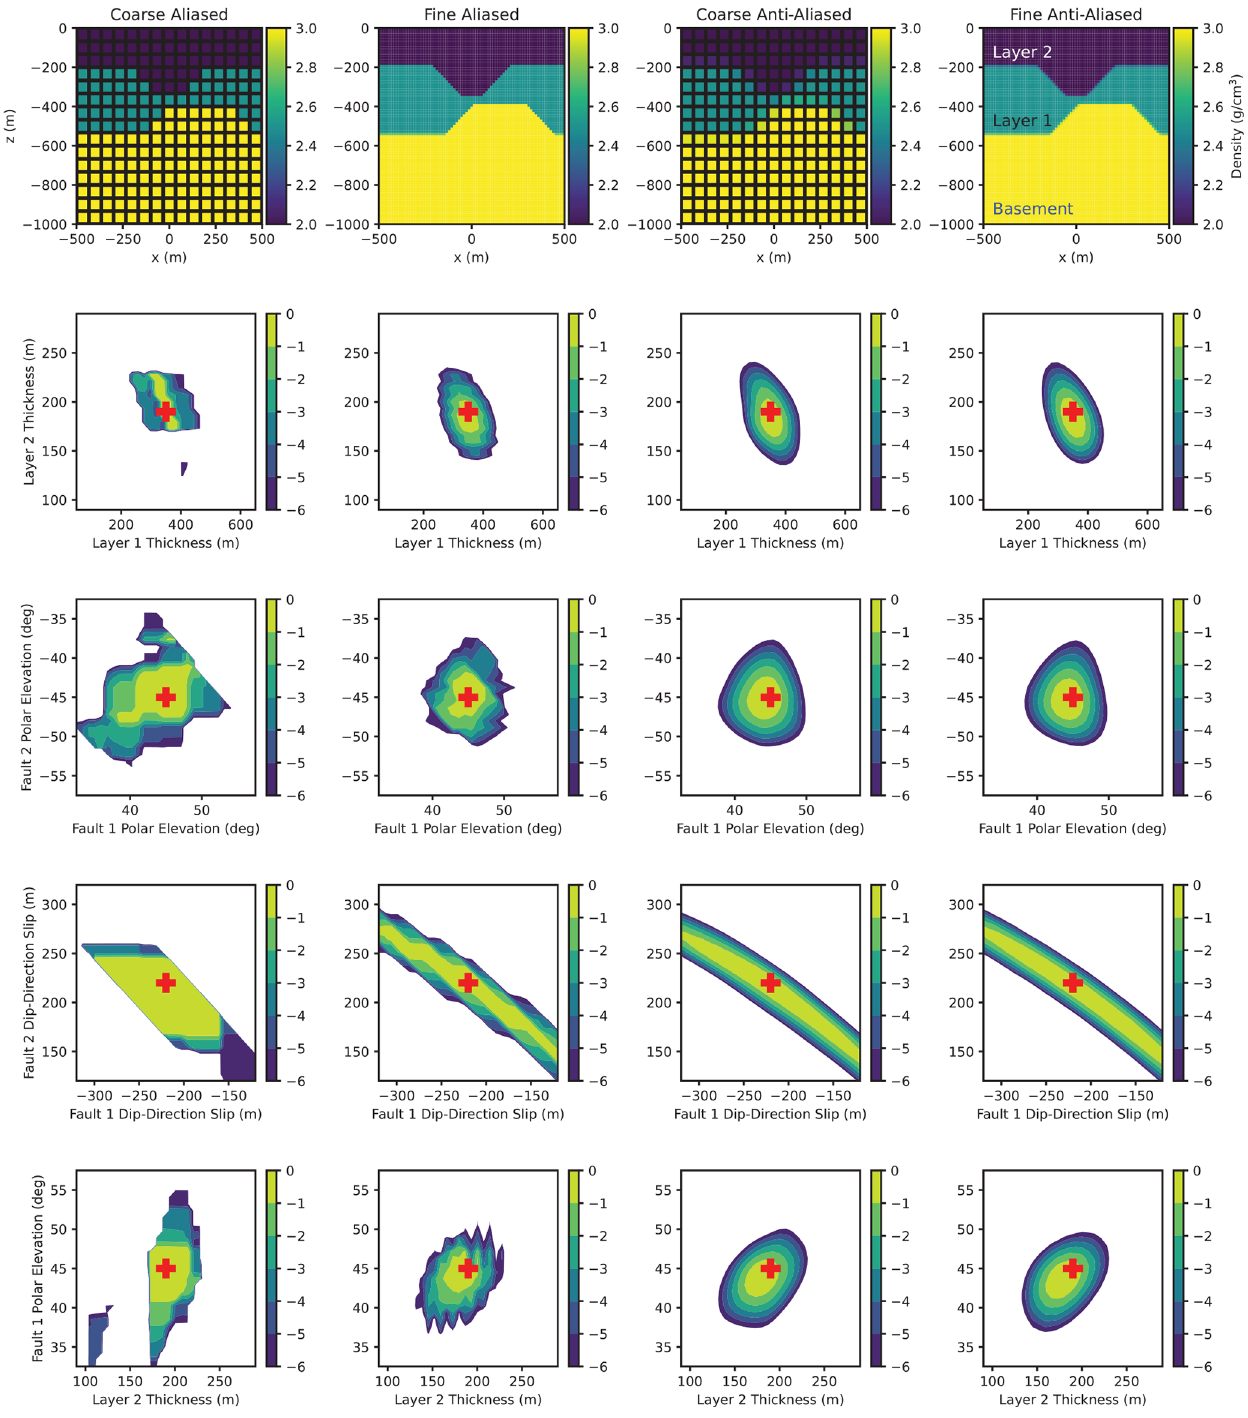
Figure 6. The log posterior distribution of pairs of parameters, denoted by θ , in kinematic Model 1, relative to the maximal value log 10 [ p( θ | d )/p( ˆ θ MAP | d ) , where ˆ θ MAP = argmax θ p( θ | d ) . In each slice, the true values of gridded parameters are marked with red crosses, and parameters that are not plotted are fixed at their true values. Columns correspond to different discretization schemes; from left to right: coarse mesh (15 3 ) with no anti-aliasing; fine mesh (75 3 ) with no anti-aliasing; coarse mesh with anti-aliasing; fine mesh with anti-aliasing. The top row shows a vertical cross section at y = 0 of the 3-D rock density field under each discretization scheme. Rows 2–5 correspond to different pairs of parameters in θ ; for row 2, θ consists of the two non-basement layer thicknesses; for row 3, θ consists of the dip direction angles of the two faults; for row 4, θ consists of the fault slips; for row 5, θ consists of the dip of the first fault and the thickness of the top